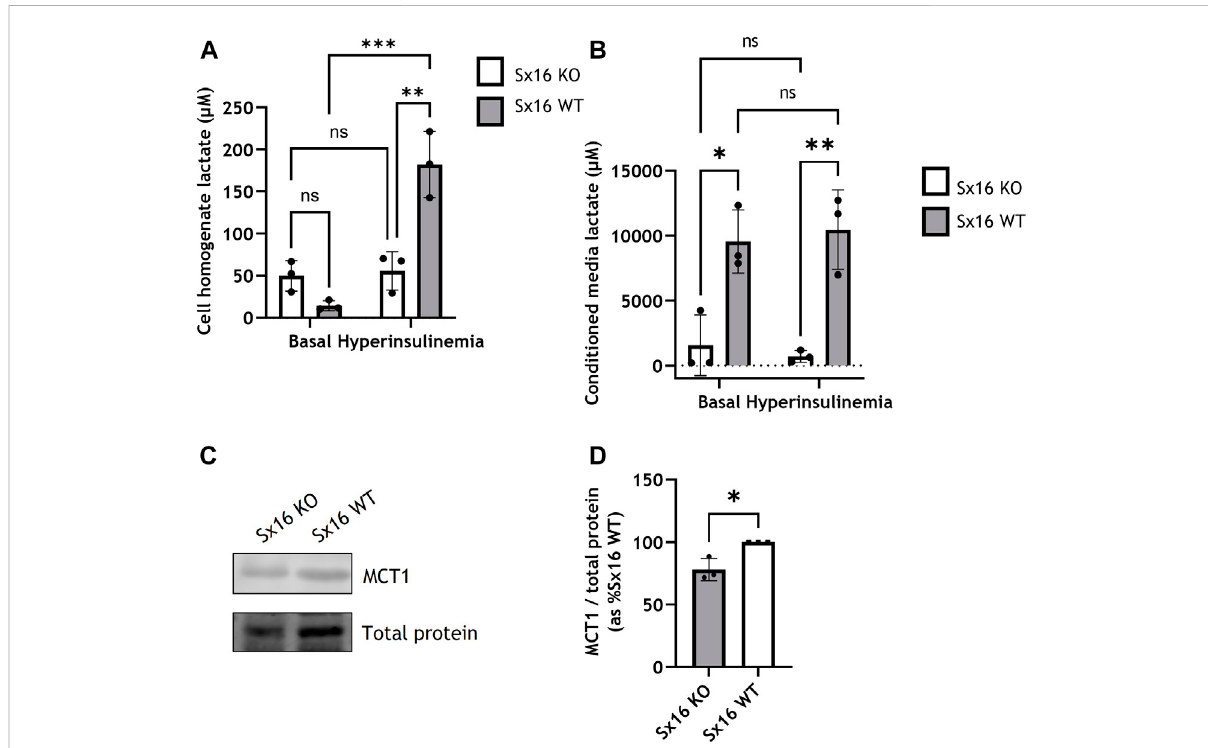
Sx16 knockout cells have altered lactate metabolism. Hyperinsulinemia was achieved by incubating cells with 300 nM insulin for 18 h in serum free media. Lactate concentration was determined from cell homogenates (A) or conditioned media (B) . (C) Cell lysates were immunoblotted for MCT1andcomparedwithtotalproteinstain (D) Quanti fi cationofMCT1wasdeterminedbycomparisontothetotalproteinstainusingdensitometric analysis from three biological replicates of each condition. Data shown represent the mean ± SD of three independent experiments. * p <